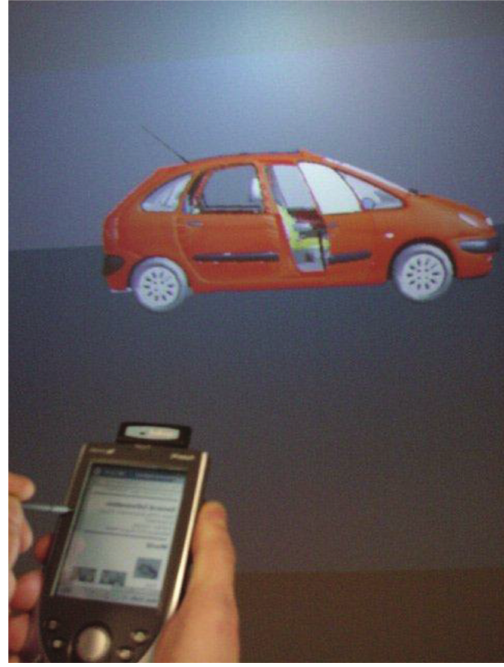
Figure 3: Decoupled interaction using a handheld